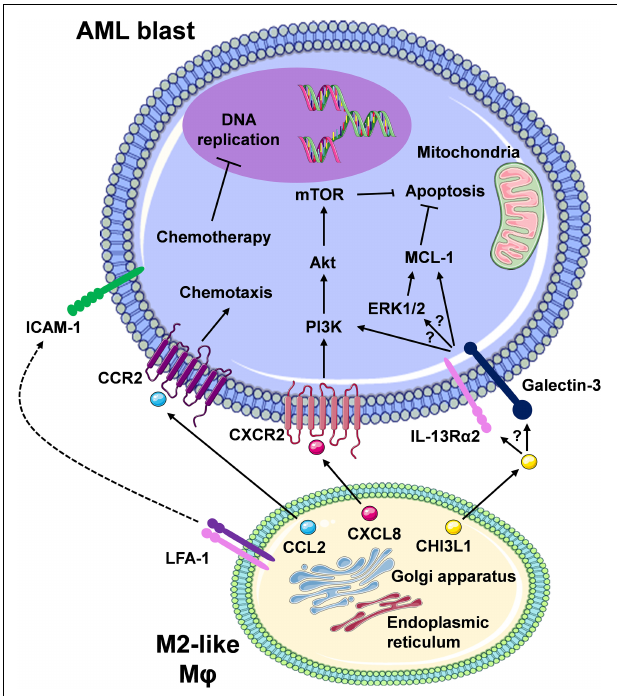
FIGURE 3 | The interaction between M2-like macrophages and leukaemic cells promotes pro-survival/anti-apoptotic signalling in AML cells. Here, we are highlighting M ϕ -AML blast interactions that mediate reduced therapeutic response and therapy resistance. Secretion of soluble factors (e.g., CCL2, CXCL8/IL-8) from M ϕ s via the ER/Golgi secretory pathway results in a number of downstream signalling events in the leukaemic blasts, many of which remain to be clearly elucidated (CCL2/CCR2, CXCL8/CXCR2, and speculated involvement of the CHI3L1/IL-13R α 2/Galectin axis). Overall, the net effect is the activation of pro-survival pathways (e.g., PI3K/Akt/mTOR, ERK1/2/MCL-1) and inhibition of apoptosis. Direct cell-to-cell contact, for example via ICAM-1-LFA-1 integrin interaction, may also result in similar intrinsic leukaemia cell responses. In turn, chemotherapy-mediated response (e.g., DNA damage) and apoptosis is prevented, which displays as chemotherapy resistance. Despite the development of targeted therapies for combination regimens with chemotherapy or as single agents, therapy resistance still remains a major limiting factor in patient outcomes due to these cell-to-cell interactions (created using Servier Medical Art).